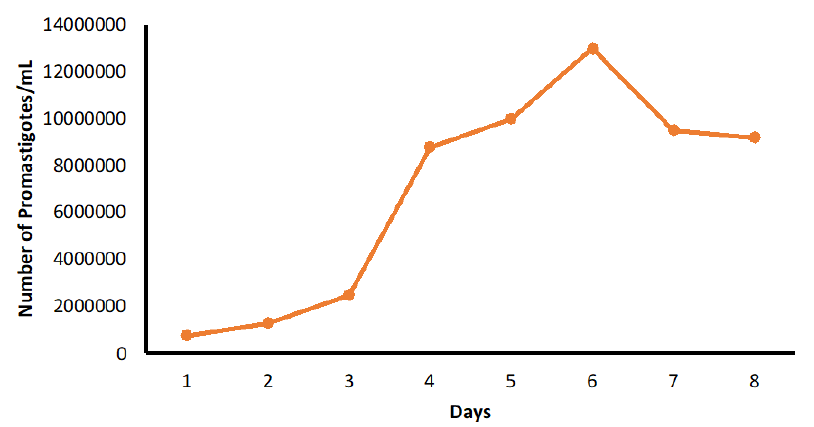
Figure 7. Growth curve for L. tropica HTD 7 in culture.